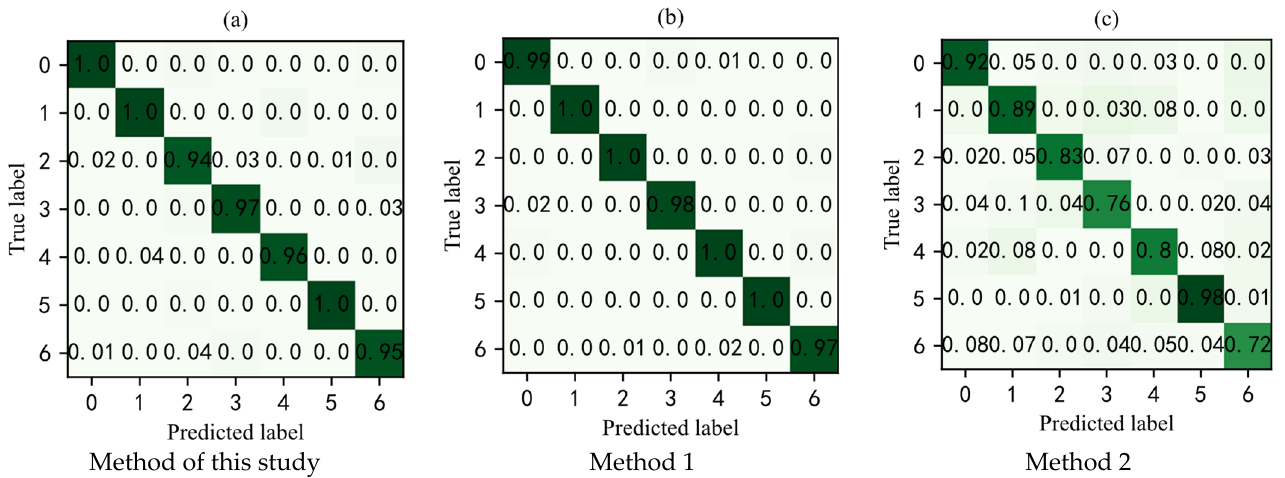
Figure 7. Confusion matrix. 0: normal; 1: sun gear tooth root crack; 2: sun gear multi-tooth surface wear; 3: sun gear single tooth surface wear; 4: planetary gear tooth root crack; 5: planetary gear multi-tooth surface wear; 6: planetary gear single tooth surface wear.